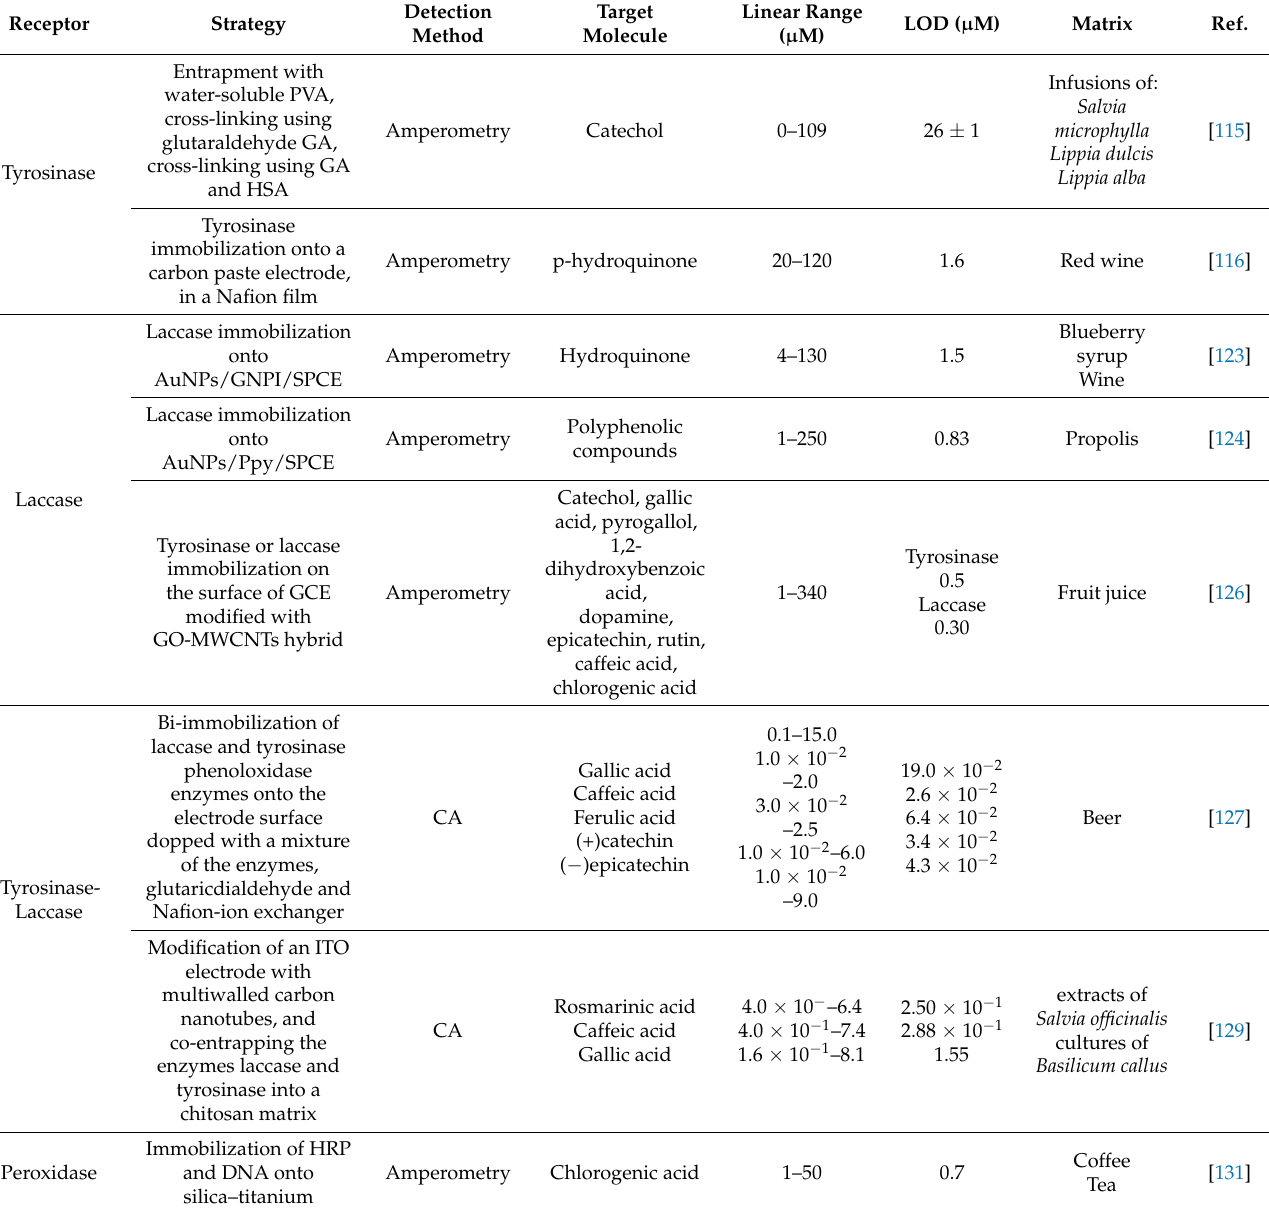
Table 2. Several examples of enzyme-based biosensors for the determination of antioxidants in food